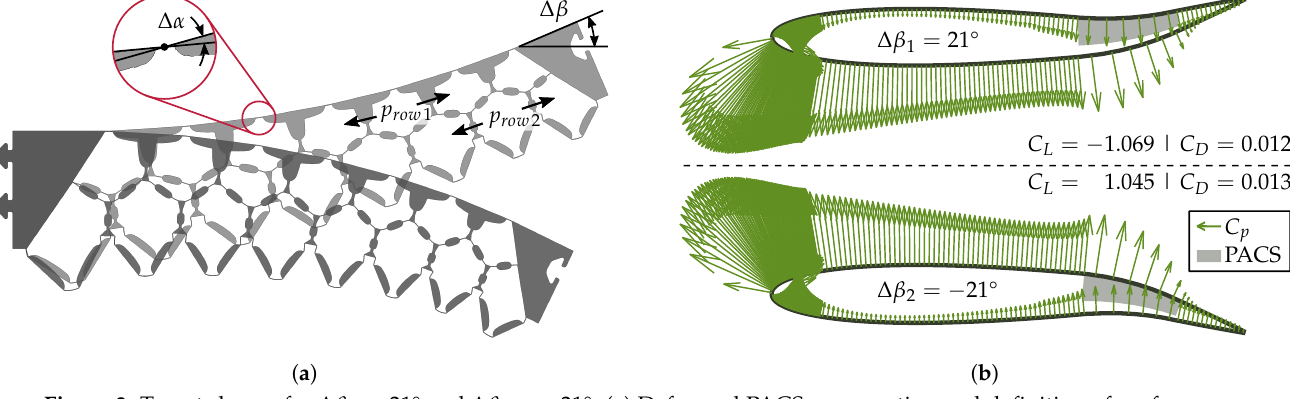
Figure 3. Target shapes for ∆ β 1 = 21° and ∆ β 2 = − 21°: ( a ) Deformed PACS cross section and definition of performance driven design parameters. ( b ) Aerodynamic loads (lift coefficient C L , drag coefficient C D and pressure coefficient C p ) calculated with XFOIL for Ma = 0.172, Re = 3.754 × 10 6 and AOA =